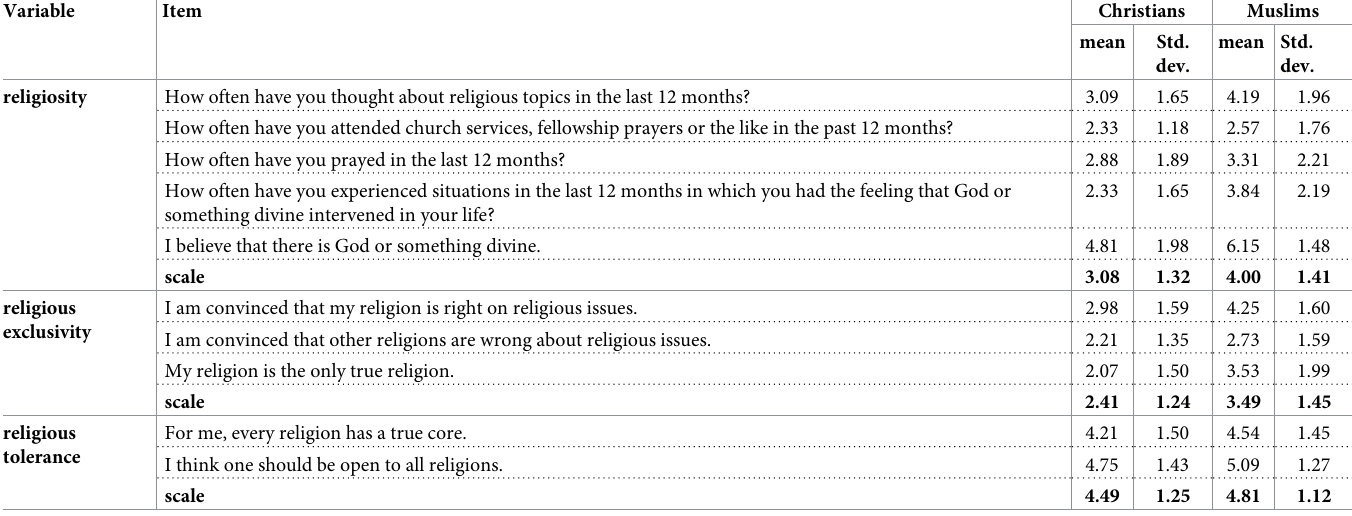
Table 1. Descriptive statistics of the religiosity and religious attitudes scales for Christians and